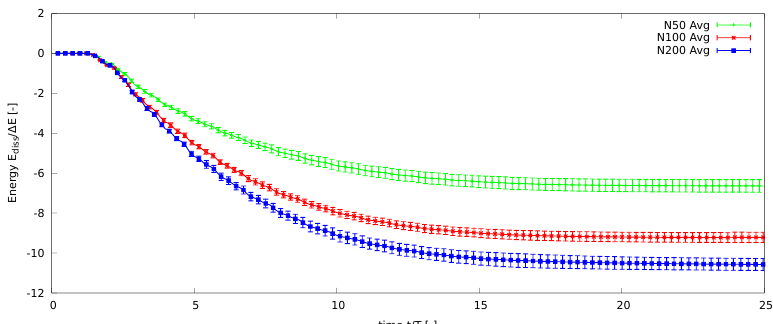
Figure 25. Average water dissipation for 2D runs with standard deviation for the 10 runs at vari- ous